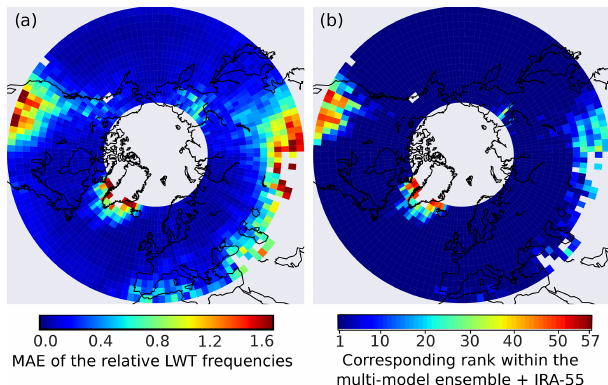
Figure 2. Mean absolute error of the relative Lamb weather type frequencies from JRA-55 with respect to ERA-Interim (a) , as well as the respective rank within the multi-model ensemble plus JRA- 55 (b) . The lower the rank, the lower the MAE and the closer the agreement between JRA-55 and